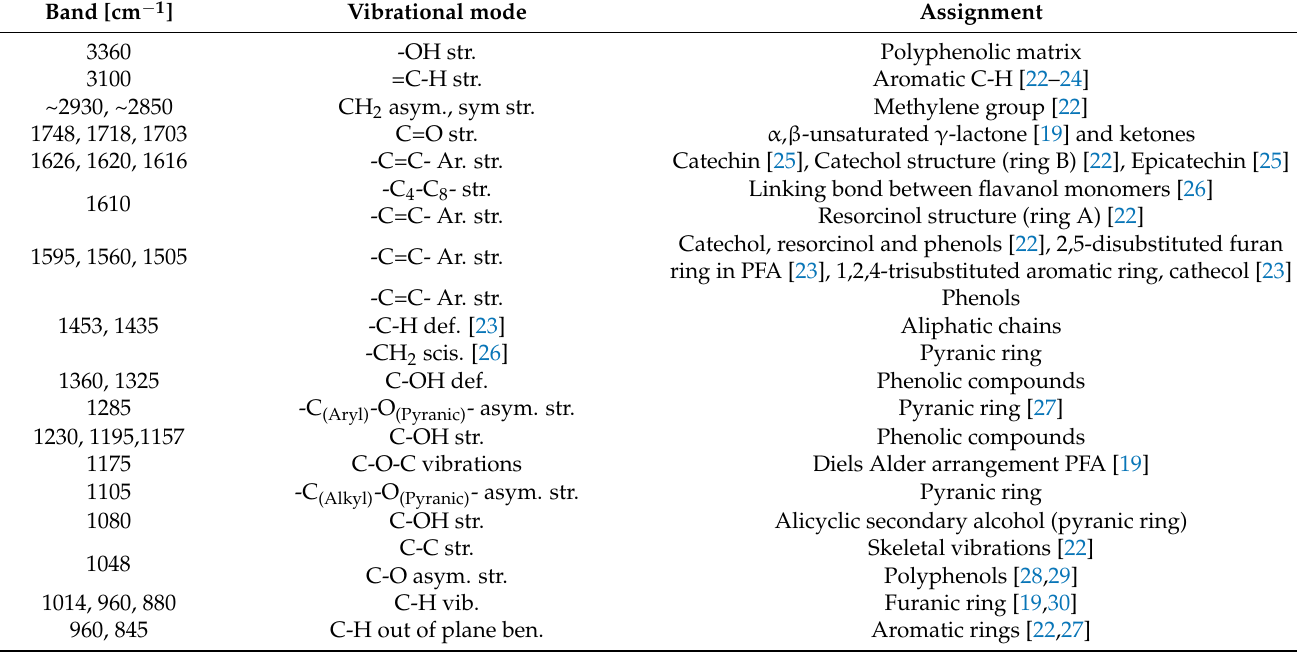
Table 1. Attribution of the most relevant spectral bands of the tannin-furanic foam. List of abbreviation: str. = stretching; asym. = asymmetric; sym. = symmetric; def. = deformation; Ar = Aromatic; scis. = scissoring; vib. =